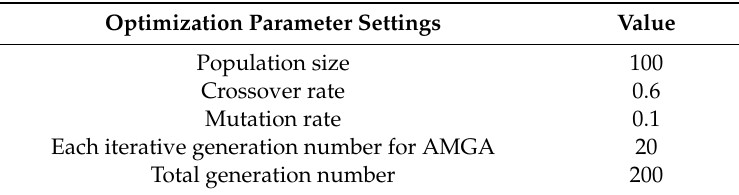
Figure 10. Evolution of fitness using genetic algorithm (GA) and AMGA. Table 3. Identical parameter settings.